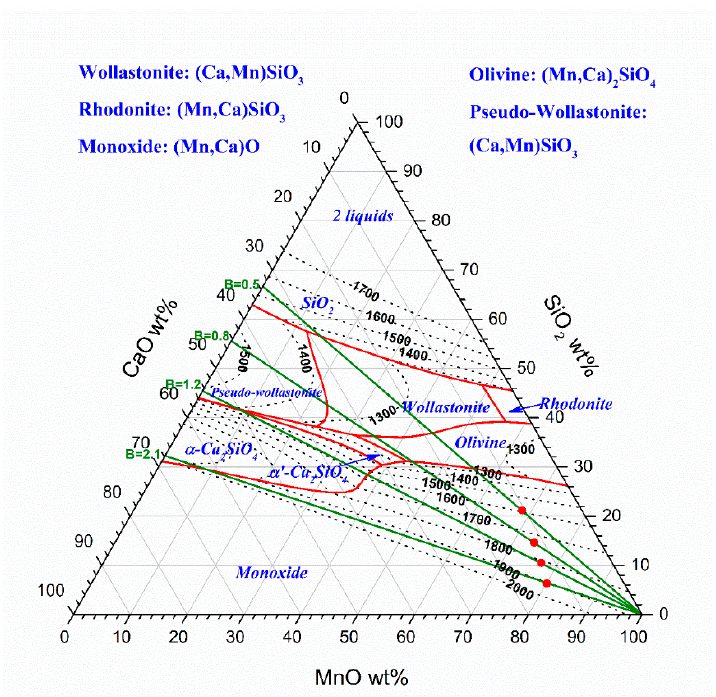
Figure 7. Calculated liquidus relations for the MnO–SiO 2 –CaO system. Green lines represent the reduction paths for Assmang charges with different basicities, red dots represent the starting points after pre-reduction.